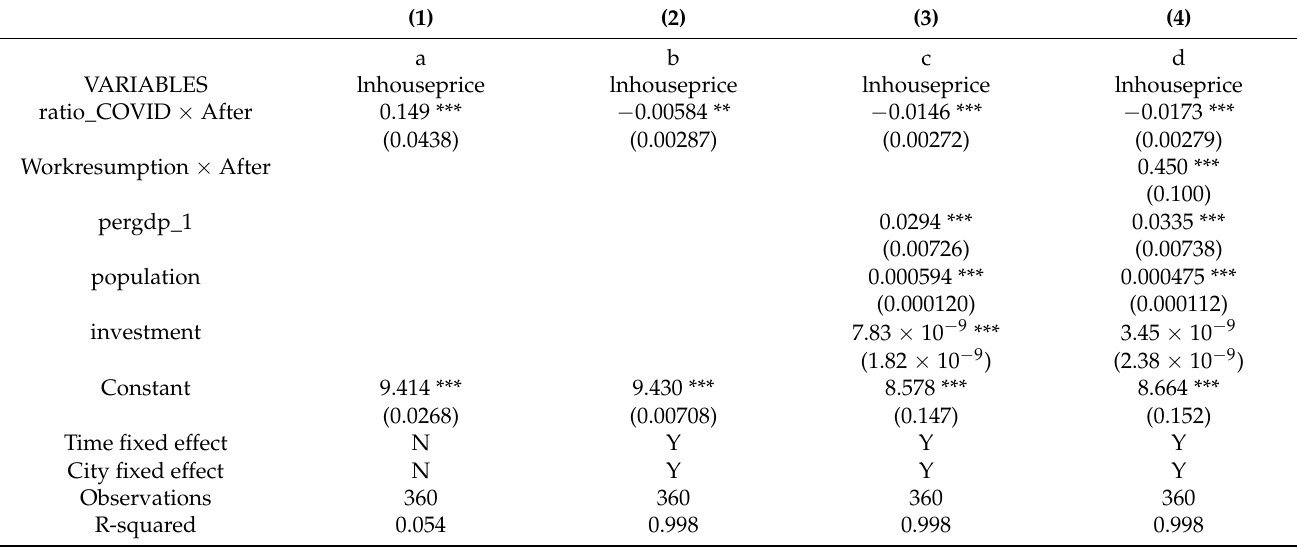
Table 3. The empirical results of COVID-19, urban resilience signals and housing